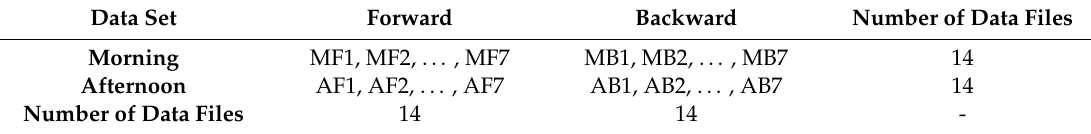
Table 1. Types of data set.